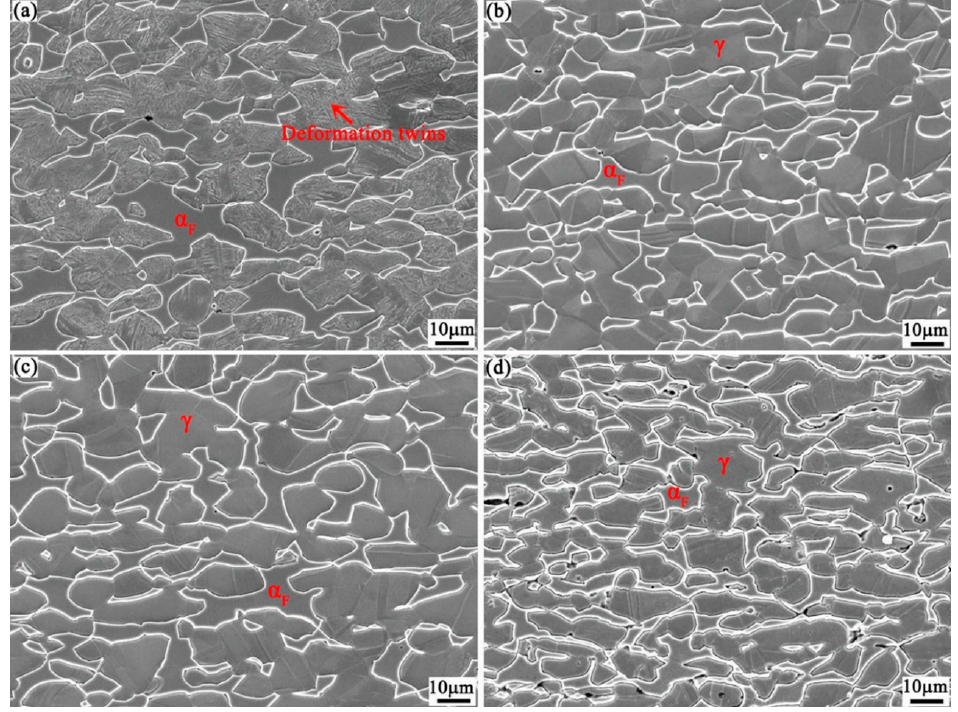
Figure 5. SEM micrographs of the experimental steel after deformation at different temperatures of ( a ) 25 °C, ε = 55%; ( b ) 300 °C, ε = 36%; ( c ) 500 °C, ε = 44%; and ( d ) 600 °C, ε = 64%.